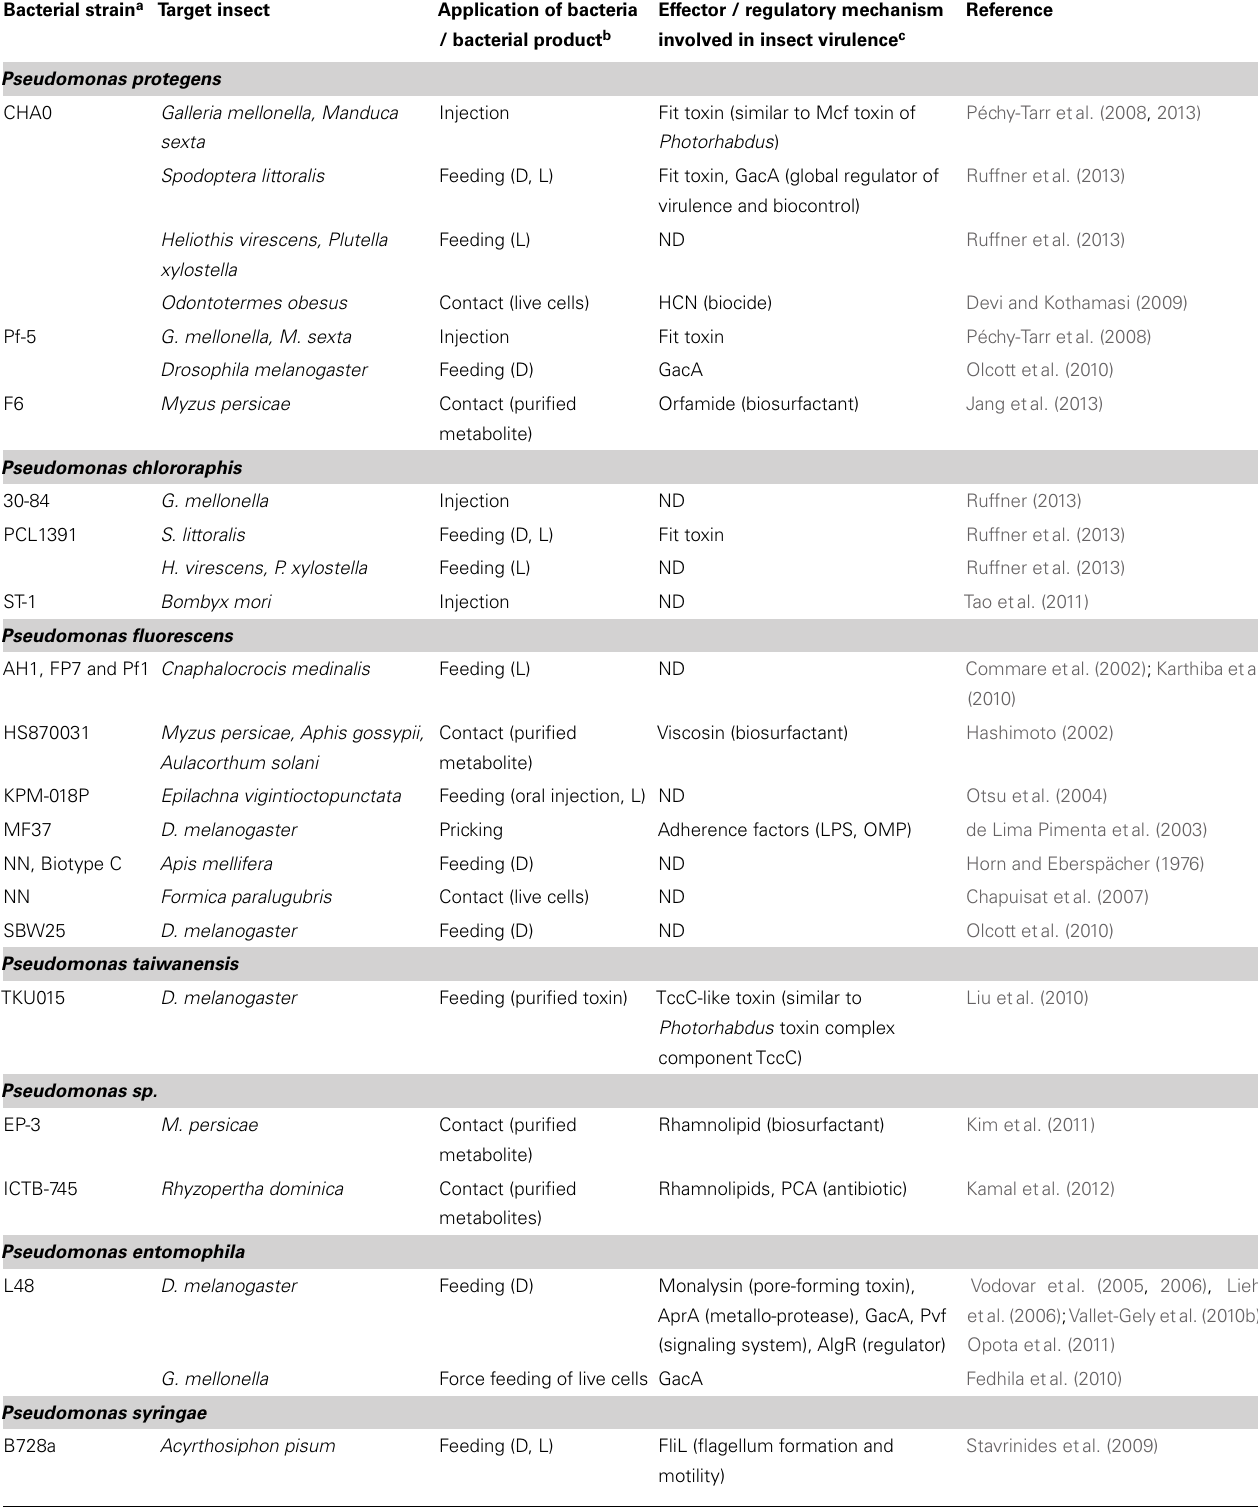
Table 2 | Insecticidal activity in Pseudomonas species and currently known effectors and regulatory mechanisms involved in insect